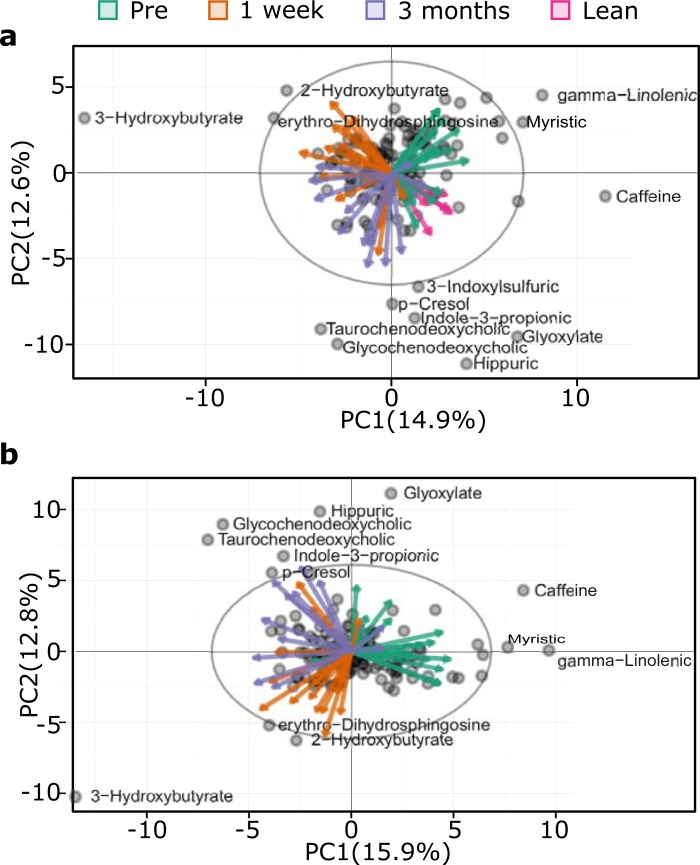
Principal component analysis and partial least square discriminant analysis of metabolomics profiles (148 metabolites and 25 patients).Projection of metabolic data a) PCA using all subjects, it shows patients correlate with surgical condition b) same as (a) but excluding lean; eclipses represent 95% confidence interval. For visualization, only scattered metabolites are labeled.